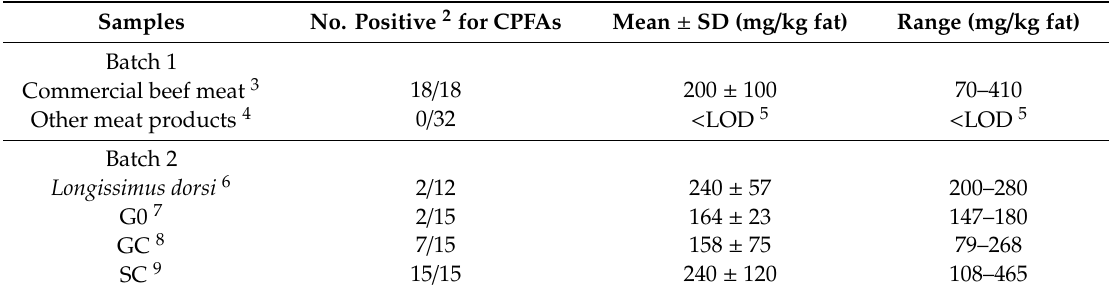
Table 1. Presence of cyclopropane fatty acids (CPFAs) 1 in meat samples.